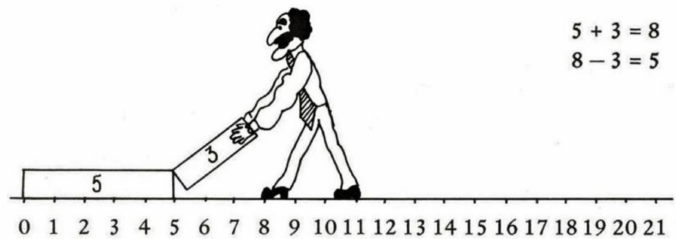
Figure 4. Relating addition and subtraction on a segmented number line in Wiskobas [39] (p. 88).